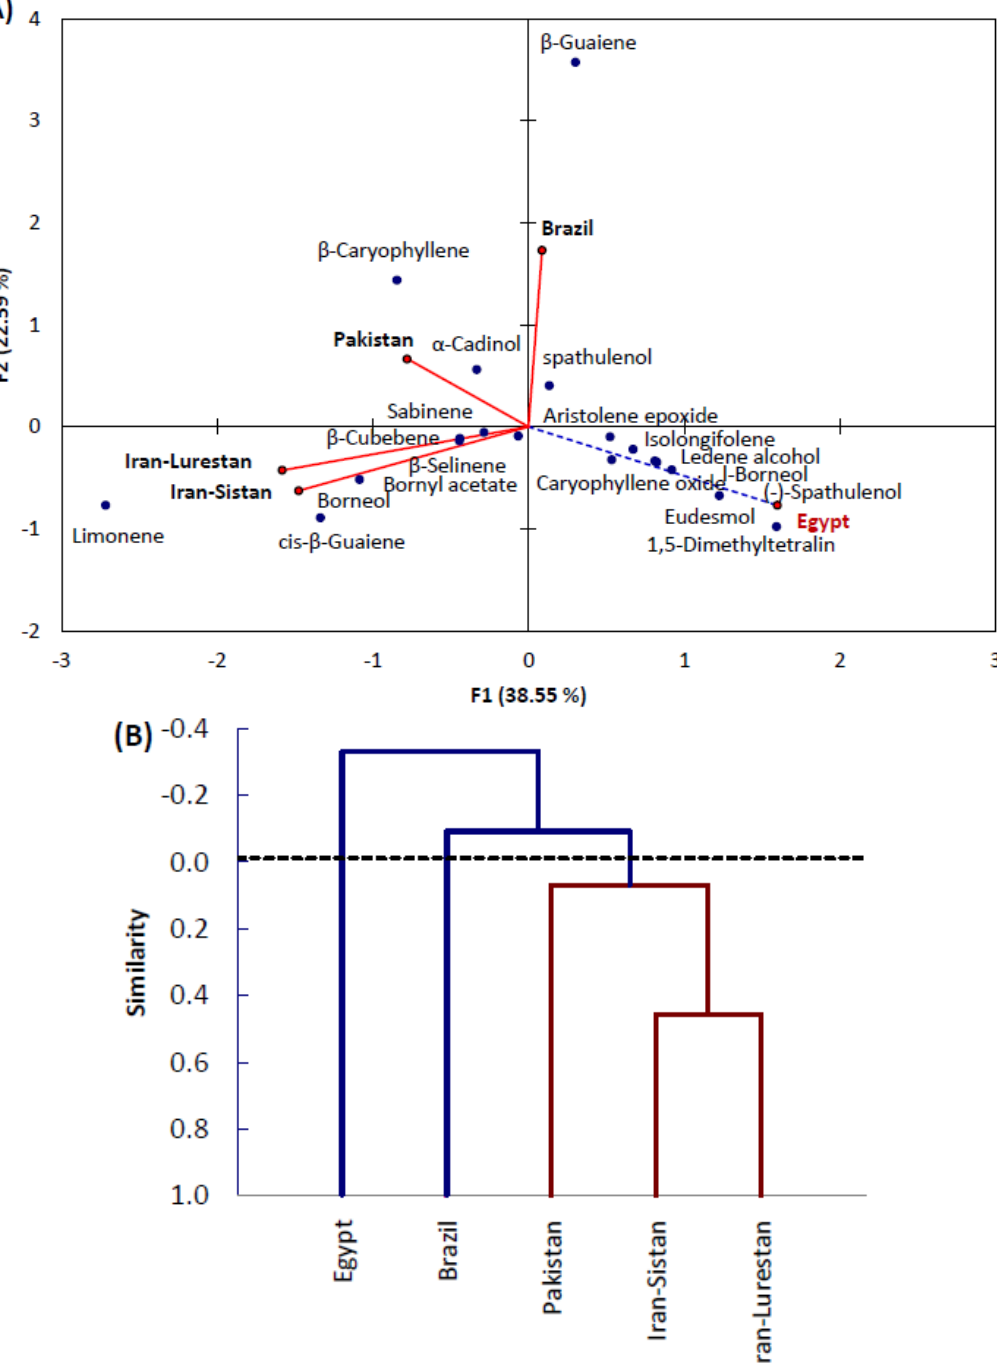
Figure 3. ( A ) Principal component analysis (PCA) and ( B ) agglomerative hierarchical clustering (AHC) based on the chemical composition of the EO derived from Egyptian ecospecies of X. strumarium leaves as well as Pakistani, Iranian, and Brazilian ecospecies.